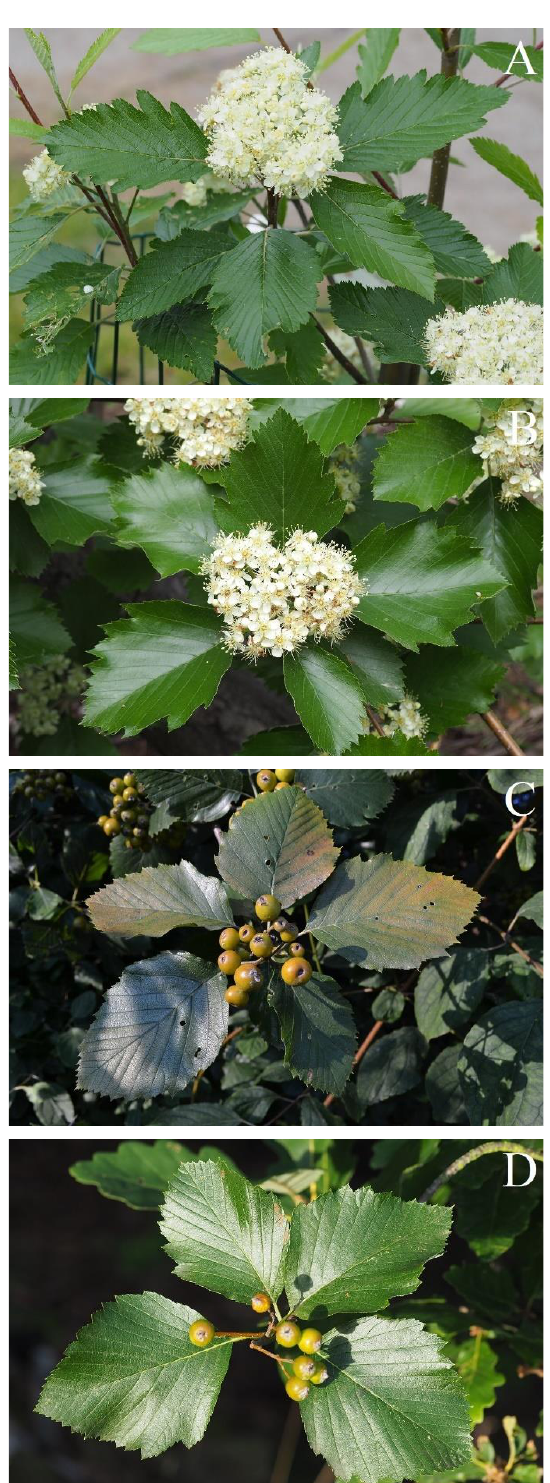
Figure 6. Sorbus species investigated. ( A ) Sorbus × abscondita . ( B ) Sorbus gemella . ( C ) Sorbus × kitaibeliana . ( D ) Sorbus omissa .